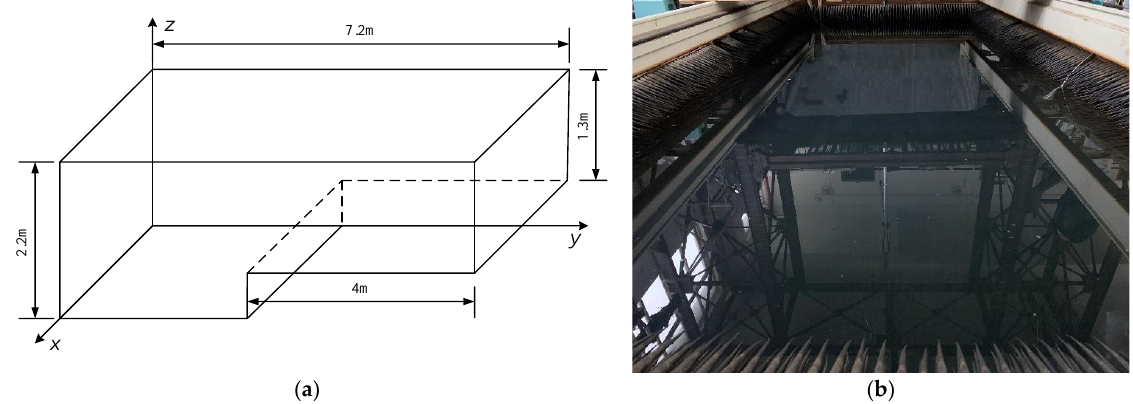
Figure 3. Available space for the anechoic pool. ( a ) Diagram of available space; ( b ) real image of available space.